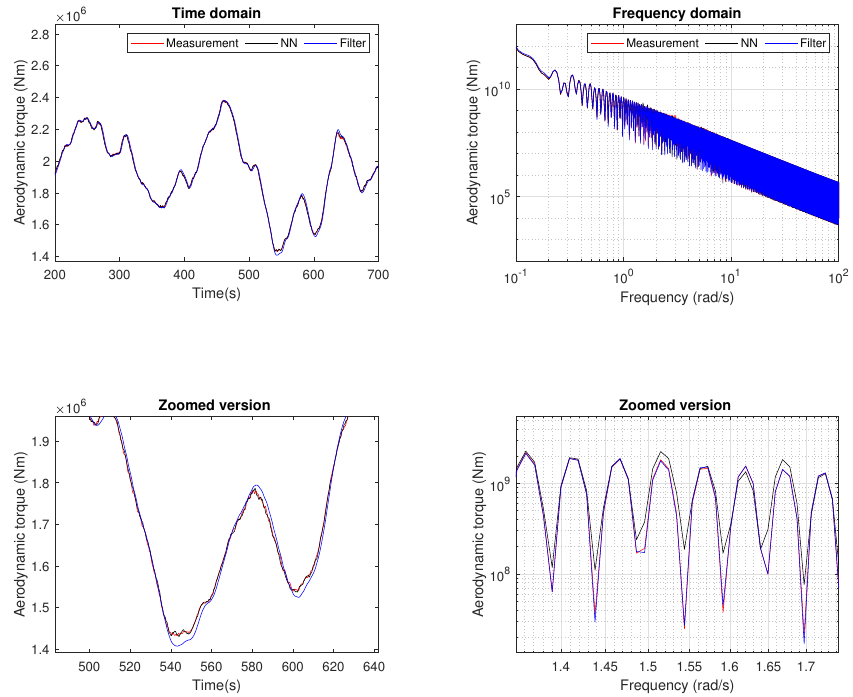
Figure 6. Scenario 1: Aerodynamic torque estimation from Turbine